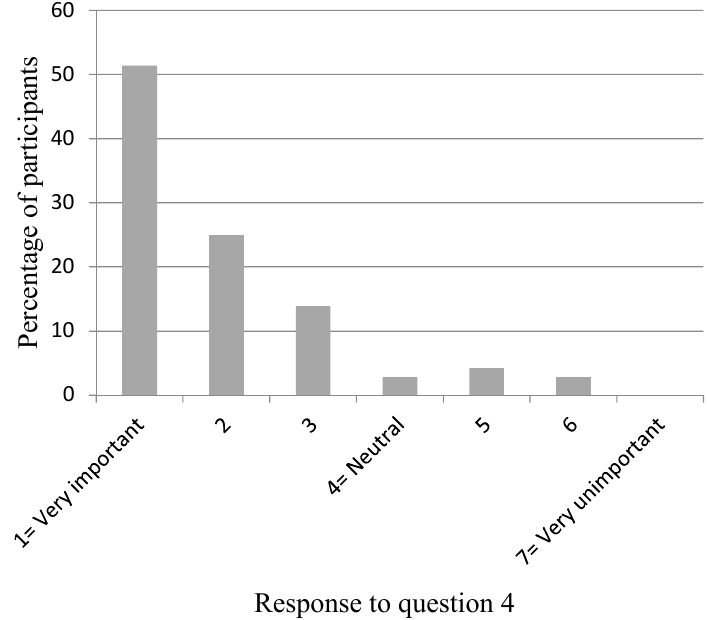
Figure 3. Participants’ response to Question 4: “How important do you perceive the edentulous patient’s values (beliefs, priorities, preferences) to be in making treatment decisions?”